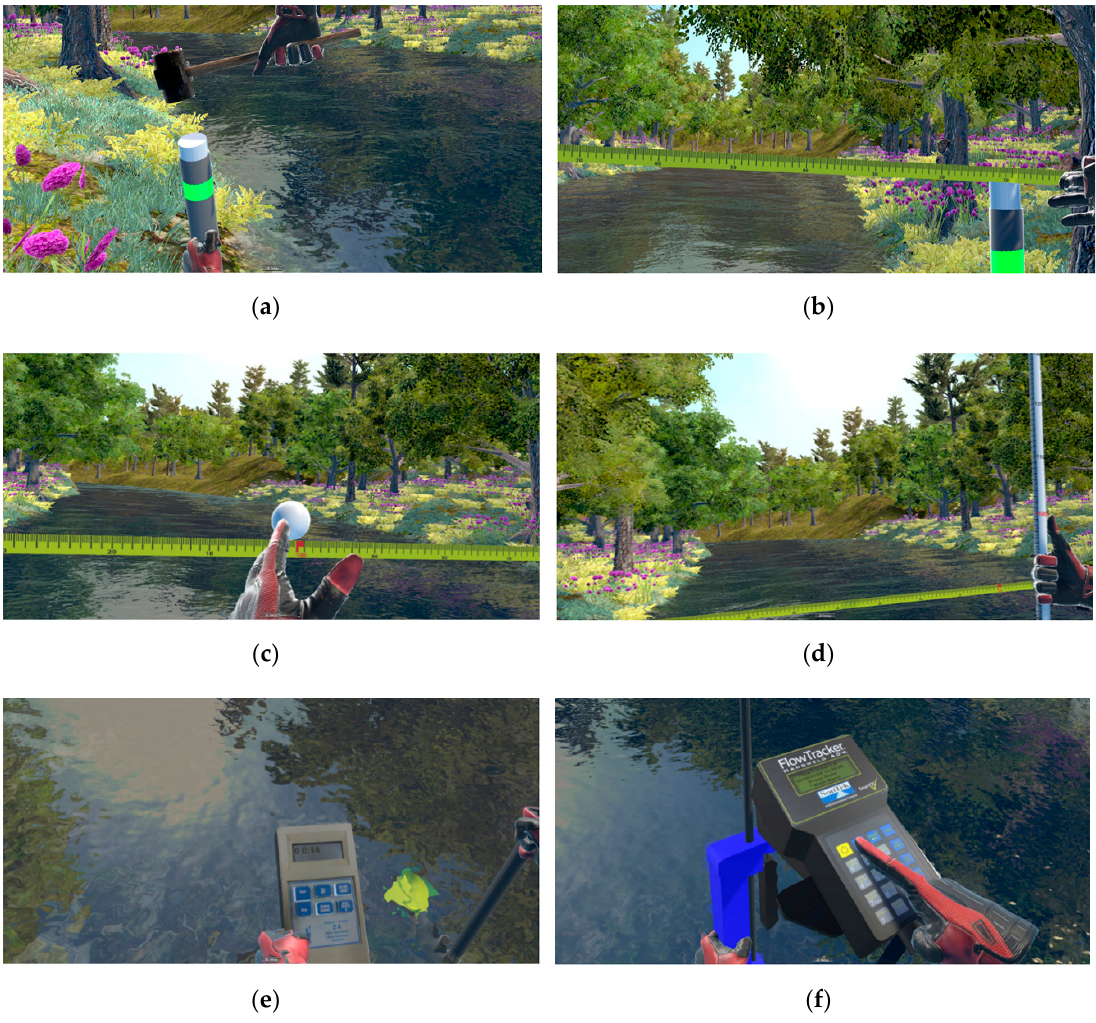
Figure 3. Different steps for the computation of the water discharge through StreamflowVL: ( a ) demarcation of the site; ( b ) estimation of width; ( c ) identification of measurement verticals; ( d ) acquisition of depth; velocity visualisation with ( e ) the current meter and ( f ) the Acoustic Doppler Velocimeter.